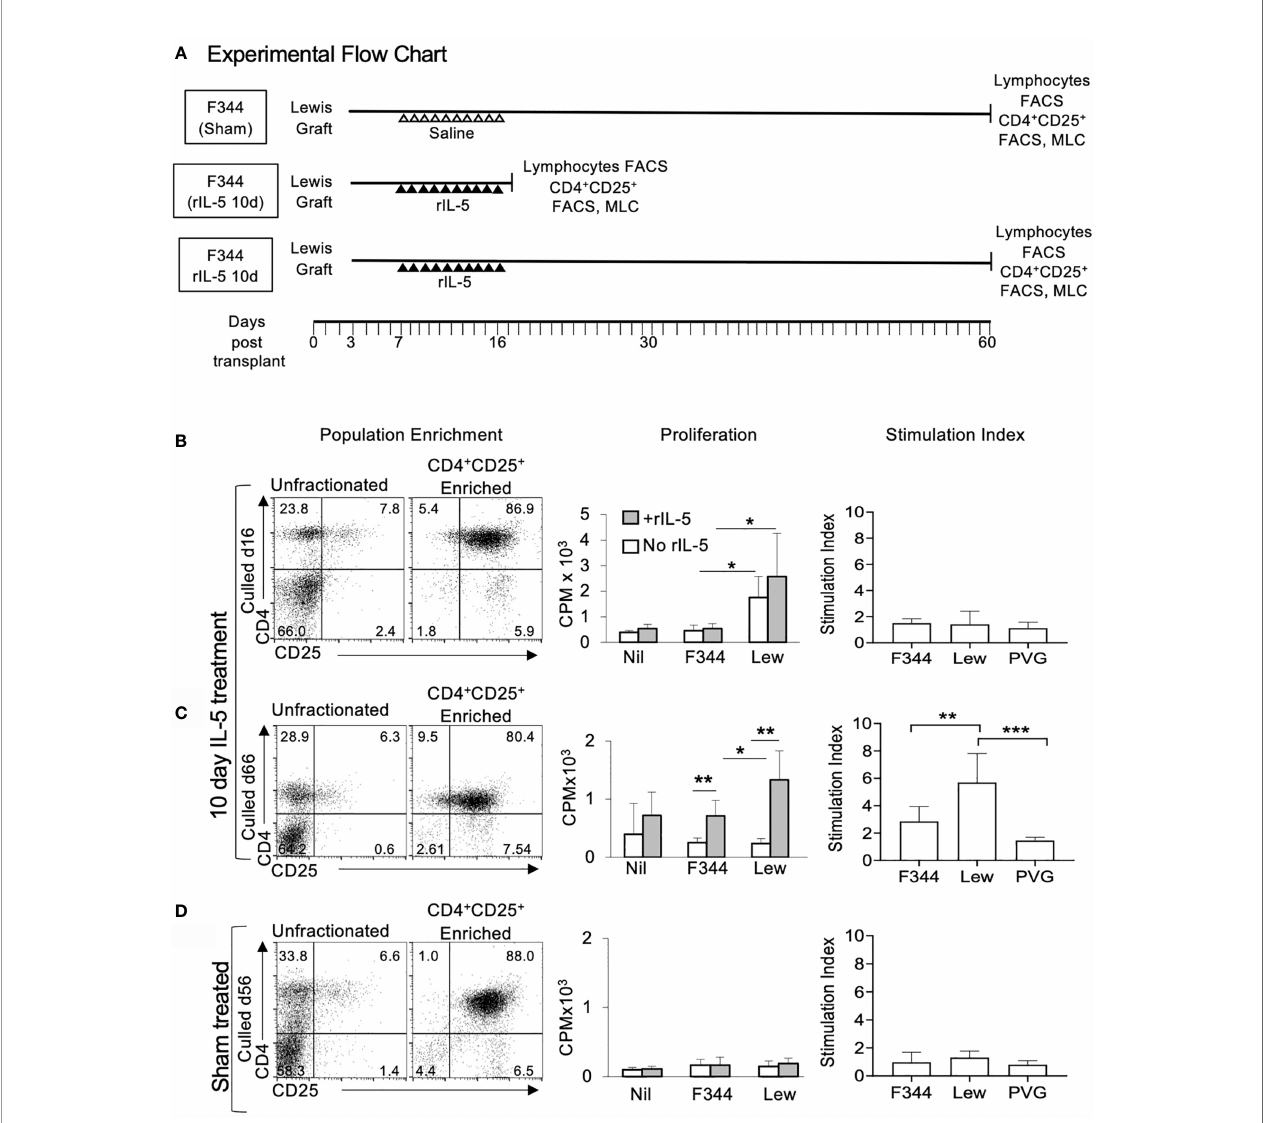
FIGURE 6 | Flow cytometry pro fi les and proliferation of CD4 + CD25 + T cells from spleen and lymph nodes from F344 recipients of Lewis cardiac allografts. (A) Experimental fl ow chart with animal treatment and collection time of peripheral lymphoid tissues for FACS and MLC. All cell donors were F344 grafted with a Lewis heterotopic heart transplant. Cells from rIL-5 treated were taken at 16 days post transplantation at the end of 10 days rIL-5 treatment, or at 66 days post- transplant. Sham treated recipients ’ cells were taken at 56 days post-transplant. (B – D) Enriched CD4 + CD25 + T cells (left column) from lymph nodes and spleens from Lewis allograft bearing F344 recipients were examined for their capacity to proliferate in MLC in response to no stimulator cells (Nil), or stimulator cells from self (F344), speci fi c donor (Lewis) or third party PVG. The understanding of the current fi ndings is dependent upon our previous fi ndings. First, naïve CD4 + CD25 + T cells, in the absence of rIL-2 or IL-4 have a very small response to alloantigen, and none to self. CD4 + CD25 + T cells from tolerant hosts do not respond to the tolerated donor strain but they do respond to third party. The proliferation of CD4 + CD25 + T cells from tolerant hosts to speci fi c donor, but not to self or third party is enhanced by addition of cytokines such as rIL-5. Effect of rIL-5 on proliferation of CD4 + CD25 + T cells to self and speci fi c donor is shown in middle column. Proliferation to third party PVG, which is fully allogeneic, is much larger to self and Lewis (data not shown). Stimulation indices were calculated as proliferation with rIL-5 in culture divided by the proliferation to the same donor stimulator cells with no rIL-5 (n=-6). (B) Cells from hosts treated with rIL-5 taken at day 16 post-transplant. CD4 + CD25 + T cells represented 7.8% of unfractionated lymphocytes and 87% of enriched cells (left panel). The enriched CD4 + CD25 + T cells proliferated to speci fi c donor, but not to self (middle panel). This proliferation was slightly enhanced by adding rIL-5 to cultures, but not signi fi cantly when assessed as Stimulation Index (right panel). (C) Cells from hosts treated with rIL-5 for 10 days and culled 66 days post-transplant, had 6.3% CD4 + CD25 + cells (left panel). CD4 + CD25 + T cells did not respond to self or speci fi c donor (middle panel). The proliferation to speci fi c donor was enhanced signi fi cantly by adding rIL-5 to the culture (middle panel) as illustrated by Stimulation Index (right panel). The response to self or third-party was not enhanced by rIL-5 (right panel). This is consistent with our hypothesis that alloantigen speci fi c CD4 + CD25 + T cells become dependent upon IL-5 for expansion. (D) Cells from hosts given sham treatment taken at 56 days post-transplantation had similar proportions of CD4 + CD25 + cells (6.6%) to animals treated with rIL-5. However, these cells did not respond to speci fi c donor alone, and rIL-5 did not enhance proliferation (middle and right panel), indicating absence of alloantigen-speci fi c Treg that depend upon IL-5. *p < 0.5, **p < 0.01, ***p <